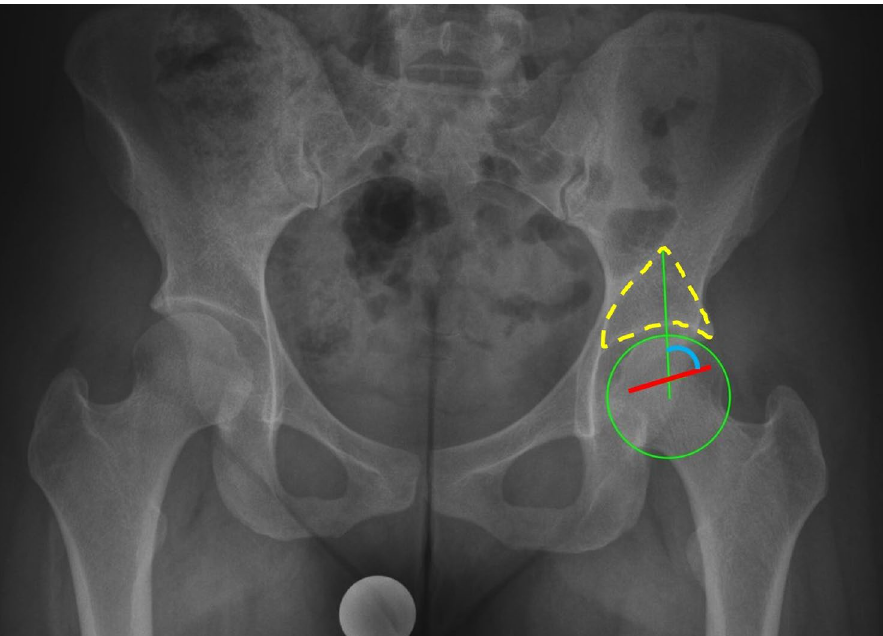
Figure 1. To measure the Gothic Arch Angle (blue semicircle), an angle between two lines is measured: The first line (green) extends between the center of the femoral head, which is determined by a best-fit circle around the femoral head (green circle), and the peak of the gothic arch (yellow dashed line). The second line (red) corresponds to the middle third of the physeal scar.